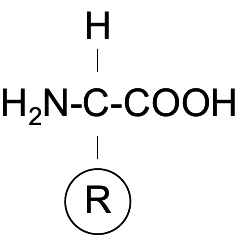
Figure 7. Chemical structure of proteinogenic α -amino acid.